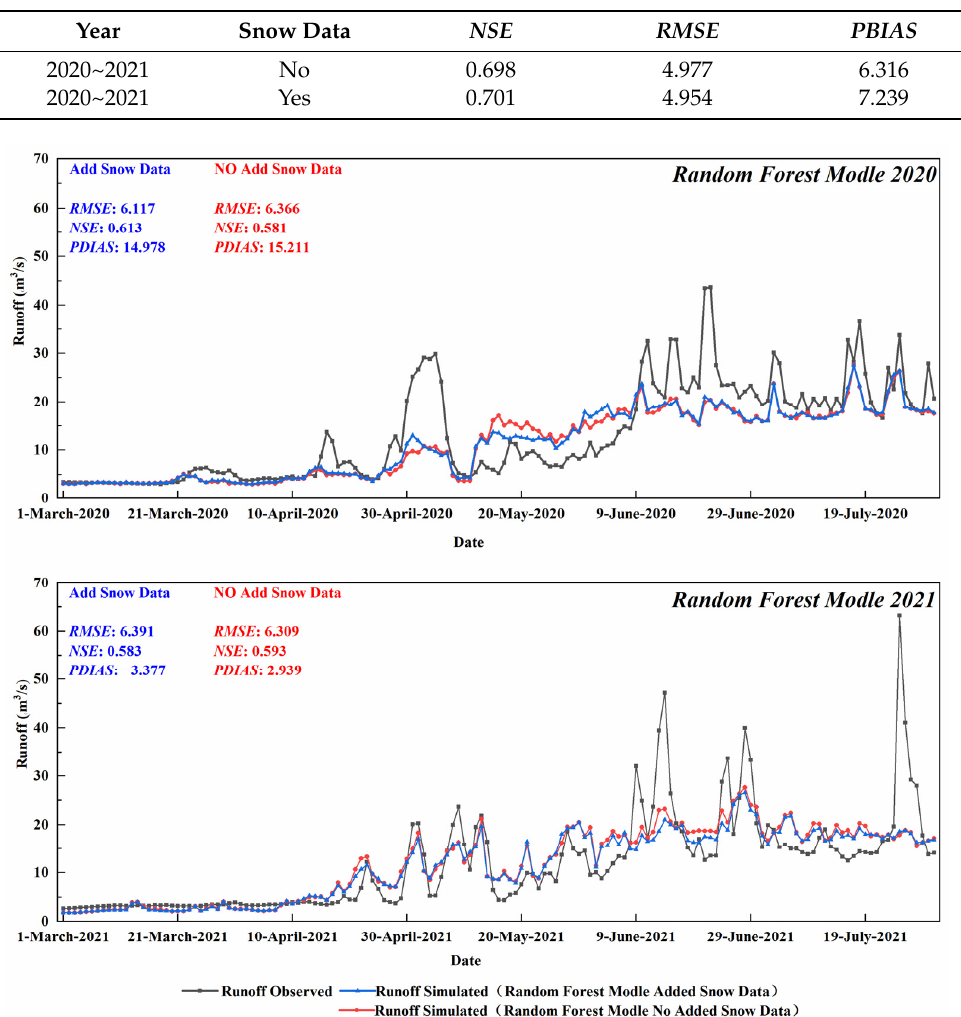
Figure 3. Simulation results for the random forest model of the Xiying River Basin from March to